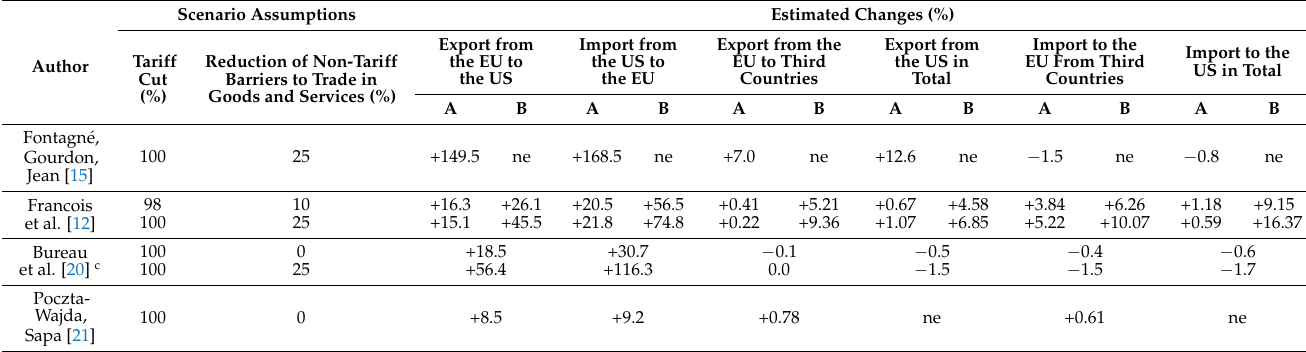
Table 2. Estimated impacts of the TTIP on the EU and the US agri-food sectors (changes in % compared to status